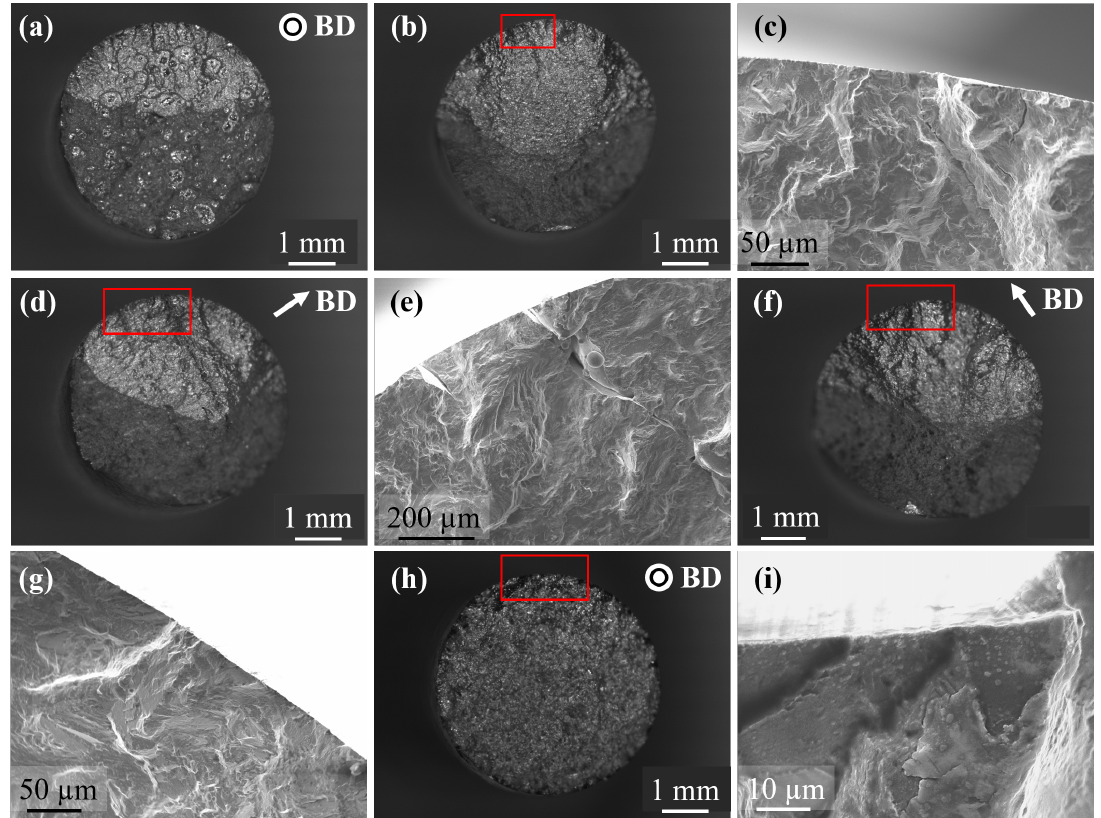
Figure 15. SEM fractographs. ( a ) AB parallel specimen with numerous LoF defects. ( b , c ) AB parallel specimen without LoF defects in the fracture surface and crack initiation from the surface. ( d , e ) AB transverse specimen with crack initiation from LoF defect at the surface. ( f , g ) AB transverse specimen without LoF defects in the fracture surface and crack initiation from the surface. ( h , i ) HSA diagonal specimen with tiny inclusions at the crack initiation